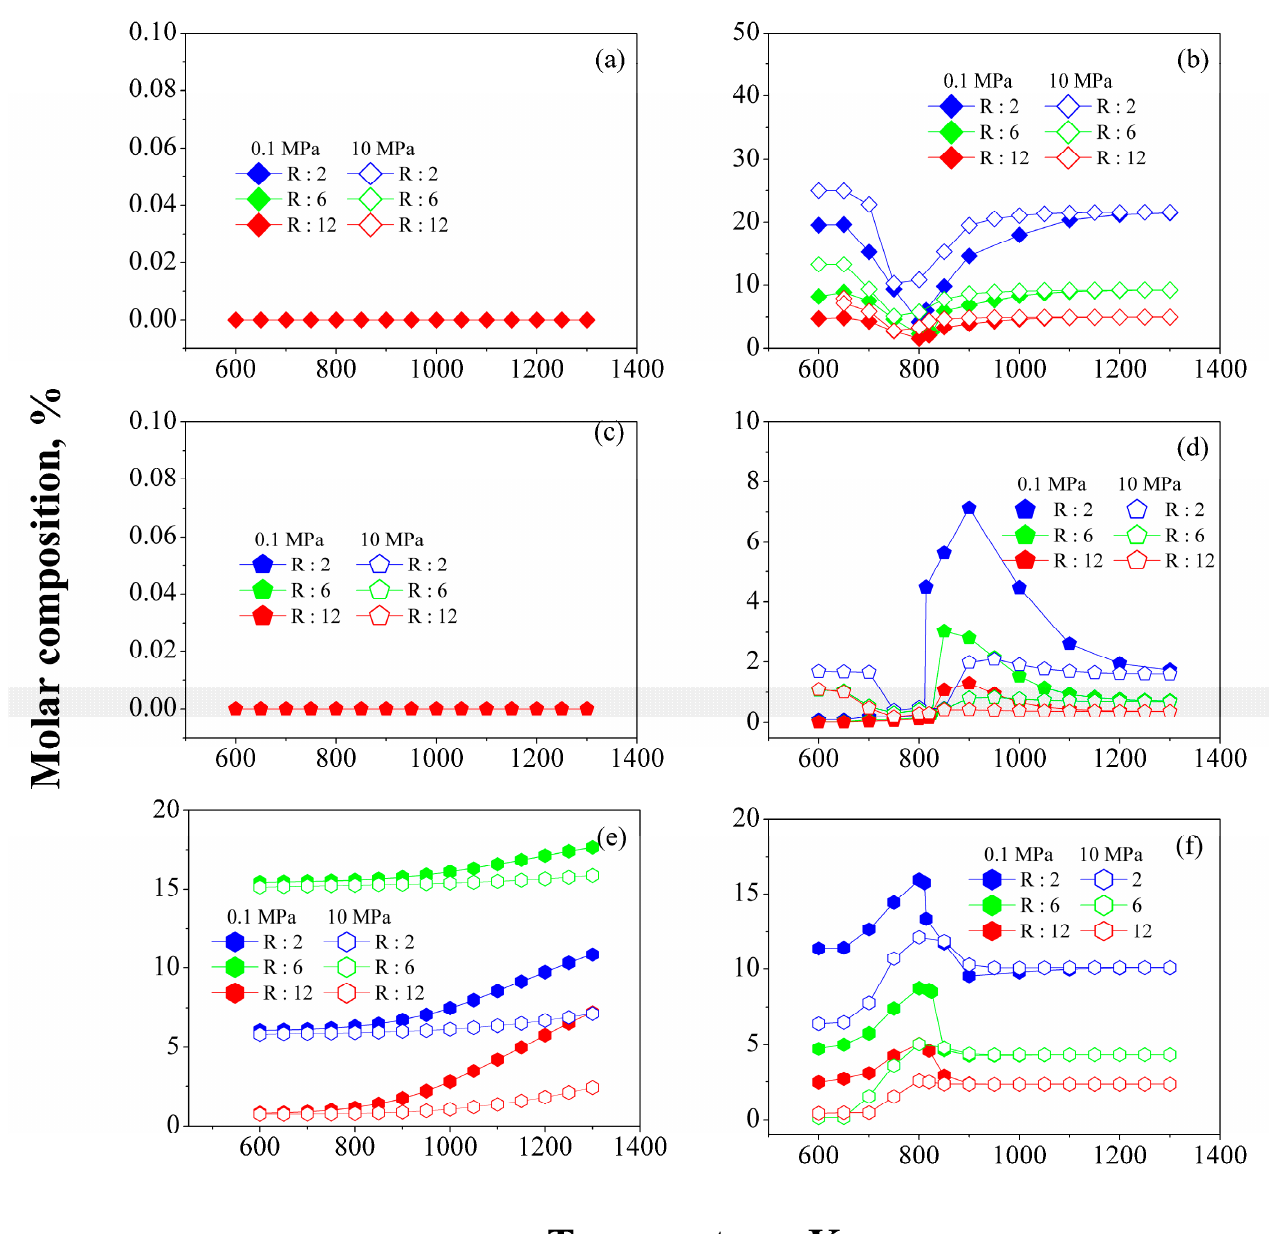
Figure 6. Effect of H 2 /HC molar ratio on liquid products: ( a , c , e ) Equilibrium. ( b , d , f ) Catalytic. ( / ) Paraffins, ( / ) Naphthenes, and ( / ) Aromatics.